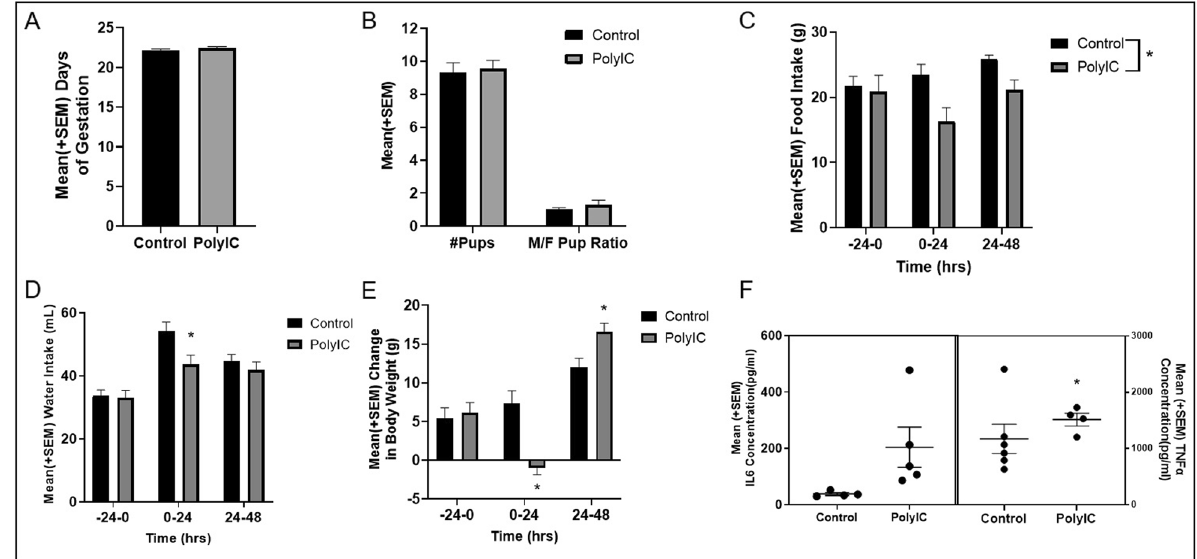
Fig. 2 The impact if polyI:C on dams. A PolyI:C did not impact the number of days of gestation compared to saline-treated dams (controls) ( p > 0.05; n = 9/group). B PolyI:C did not impact the number of pups born or M/F pup ratio compared to control dams ( p > 0.05; n = 9/group). C Dams treated with polyI:C ate less food than control dams overall ( p = 0.002; n = 9/group). D Dams treated with polyI:C drank less water than control dams 24 hours after injection ( p < 0.05; n = 8/group). E PolyI:C caused a reduction in body weight 24 hours after injection, but an increase 48 hours after injection, compared to control dams ( p < 0.05; n = 9/group). F The im p act of polyI:C on IL6 and TNF α concentration 2 hours post-injection. Each dot represents an individual dam. PolyI:C signi fi cantly enhanced TNF α levels ( p = 0.006; n = 4 – 5/group), but not IL6 levels ( p = 0.08; n = 4 –